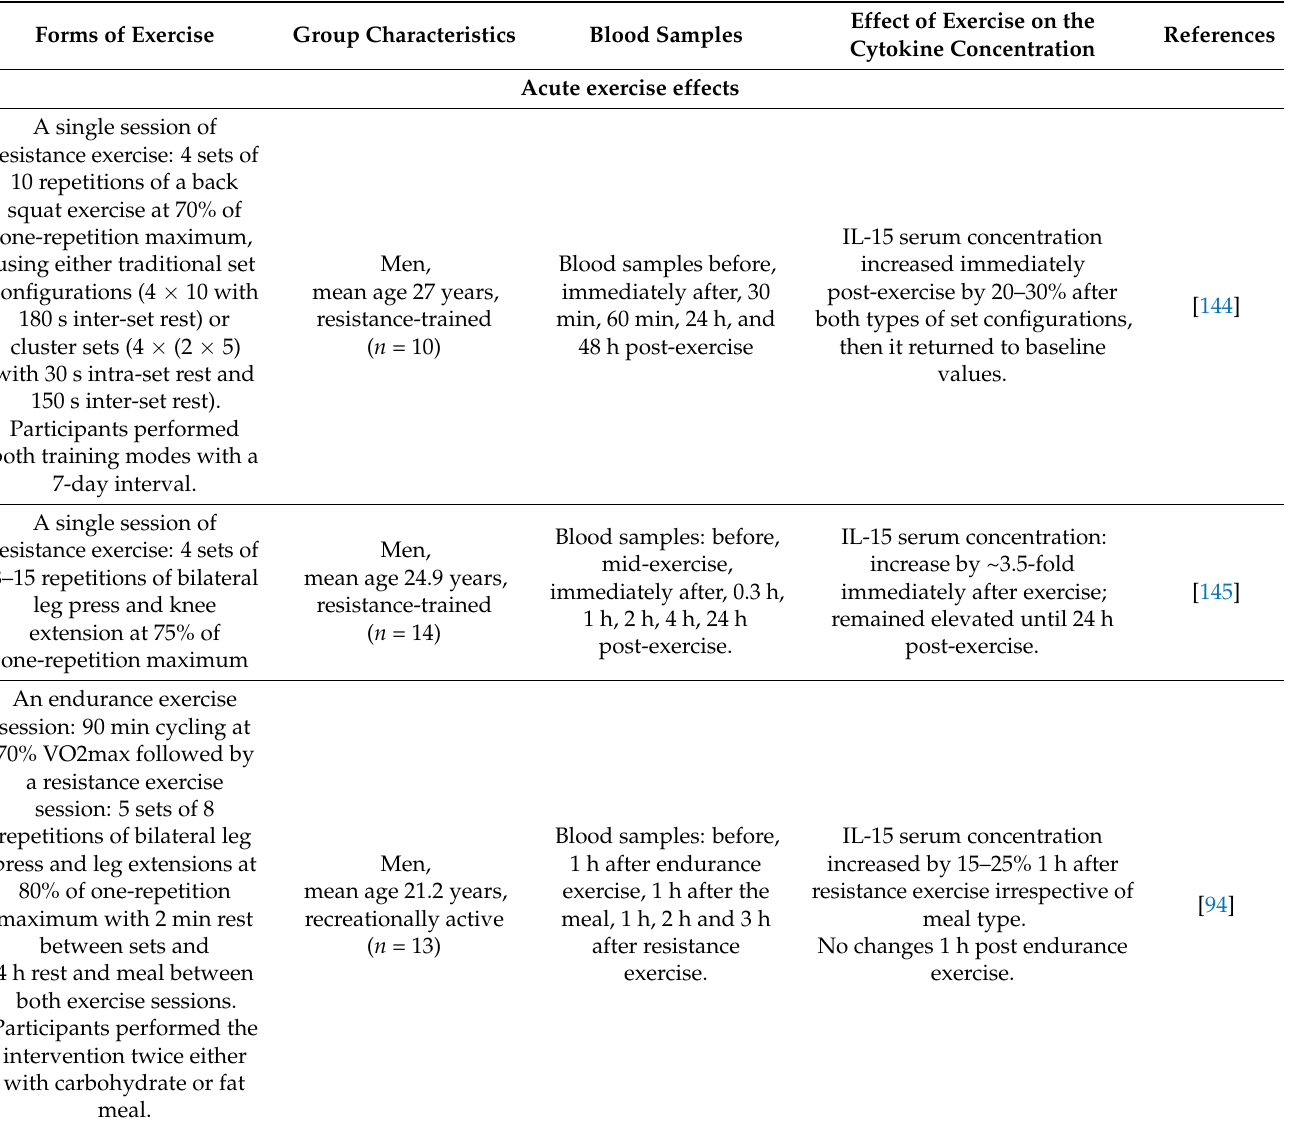
Table 7. Effects of exercise on